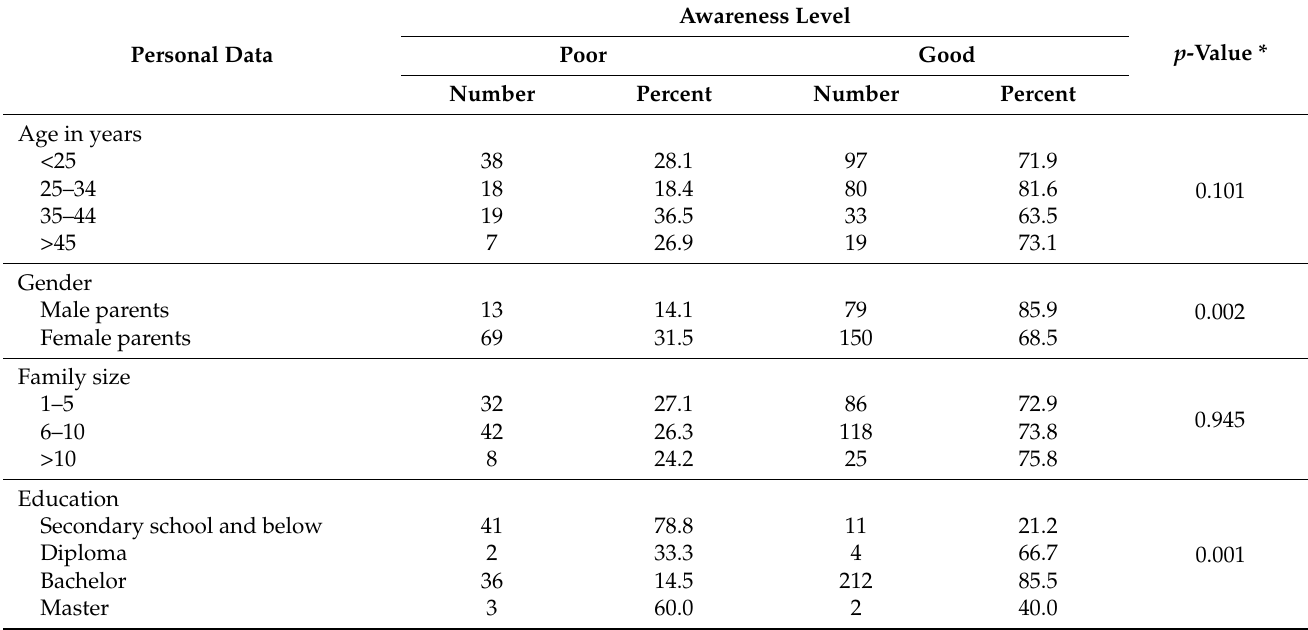
Table 1. Awareness level distributed by parents’ data in Aseer region, southwestern Saudi